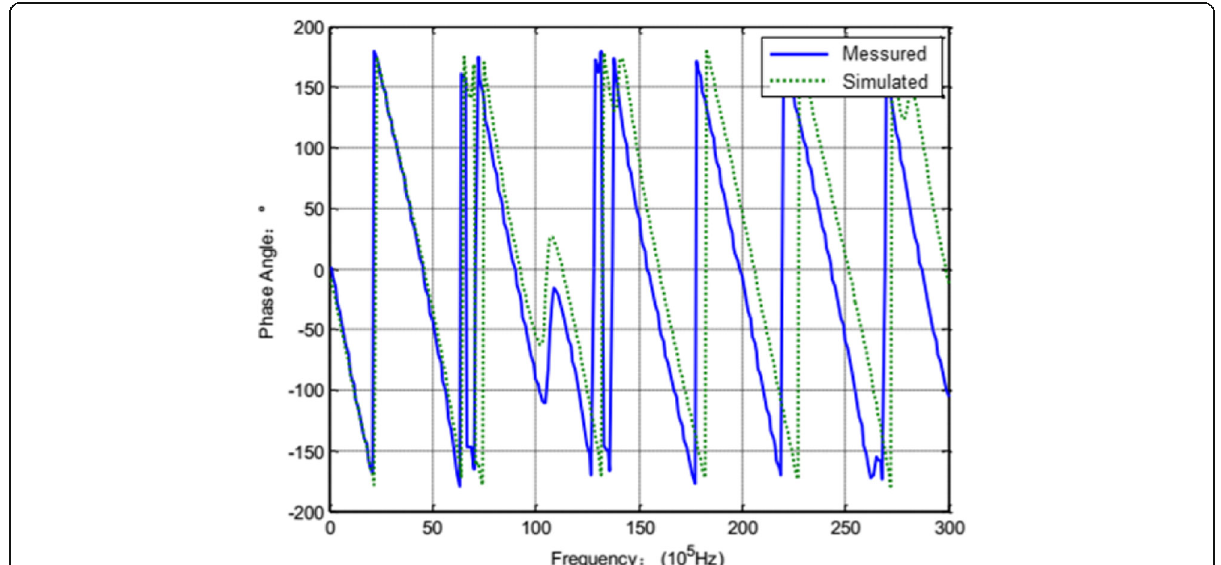
Fig. 10 Laboratory test and simulation results of phase-frequency